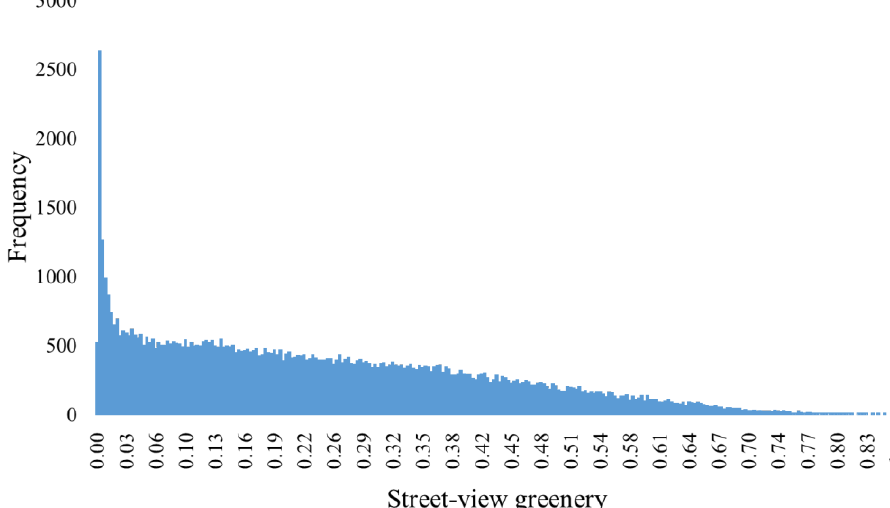
Table 1. The characteristics of the study variables.